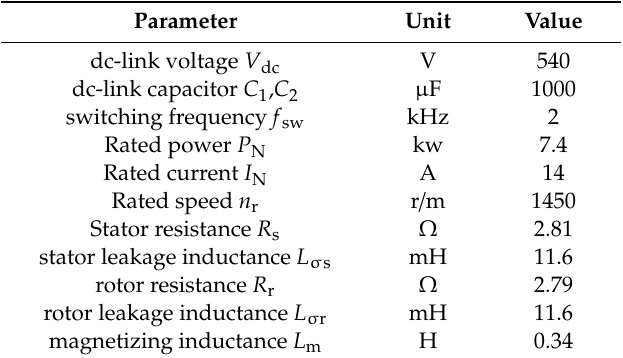
Figure 9. Experimental results for CPWM, DPWM3, and the proposed strategy when m = 0.2: ( a ) CPWM; ( b ) DPWM3; ( c ) the proposed strategy.